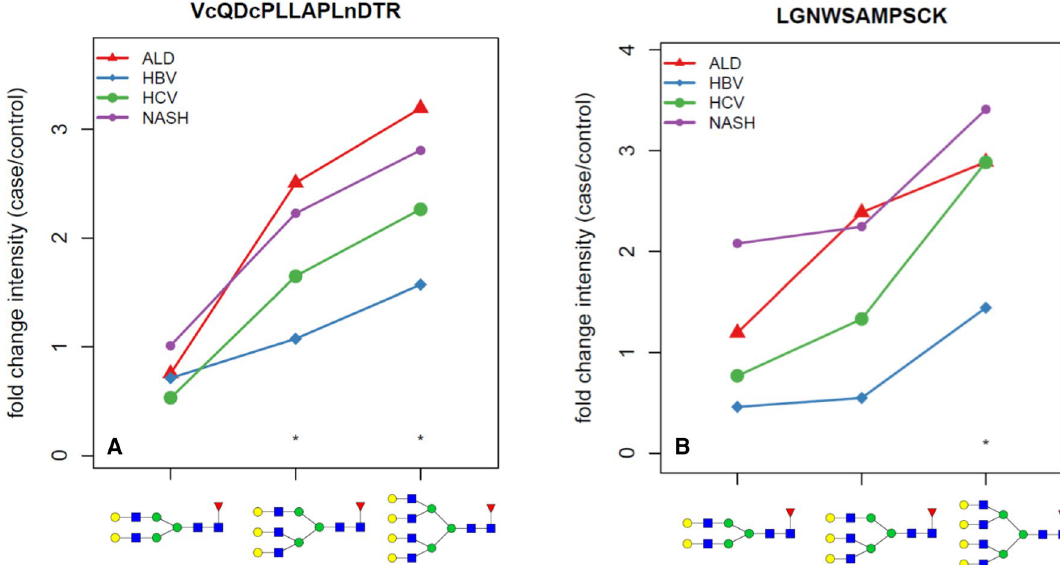
Figure 5. Average ratio of the increase in the intensity of the following core fucosylated glycopeptides in the liver cirrhosis groups of four etiologies compared to the healthy controls: A. bi-, tri- and tetra-antennary glycoforms of the VCQDCPLLAPLNDTR peptide of Alpha-2-HS-glycoprotein; B. bi-, tri-, and tetra-antennary glycoforms of the LGNWAMPSCK peptide of